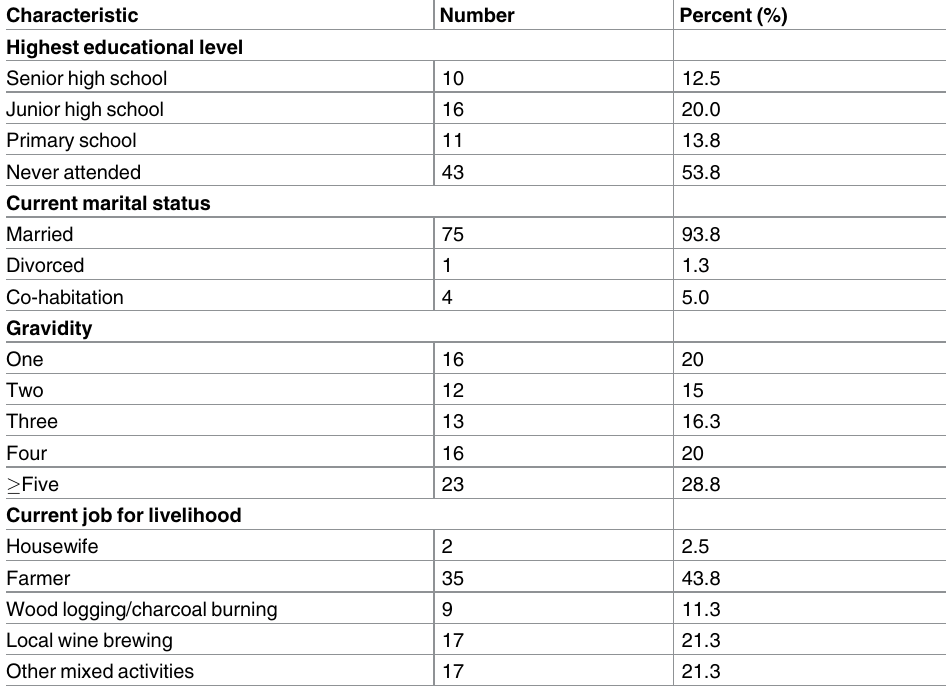
Table 2. Basic demographic characteristics of expectant mothers (N =